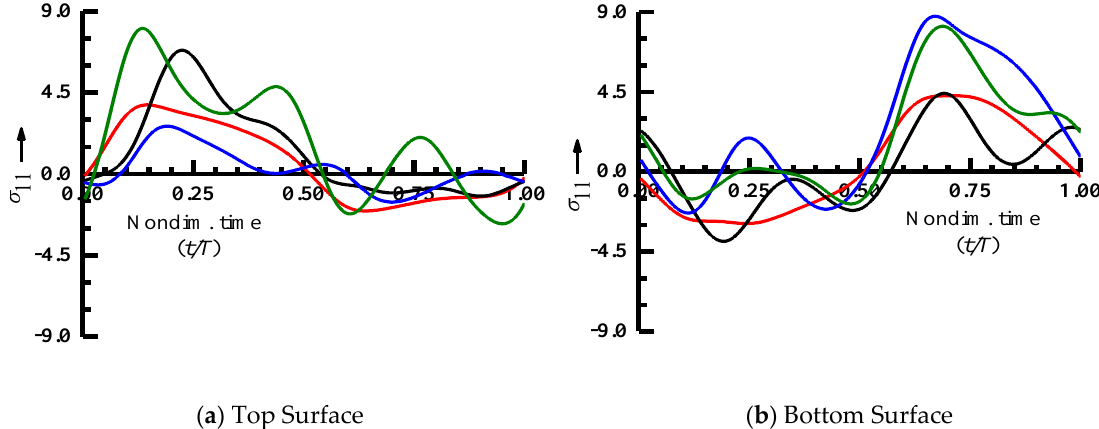
Figure 4. Nonlinear periodic stress (σ 11 ) variation at the center of ( a ) top and ( b ) bottom surfaces corresponding to peak amplitude in the nonlinear response of Figure 2b.